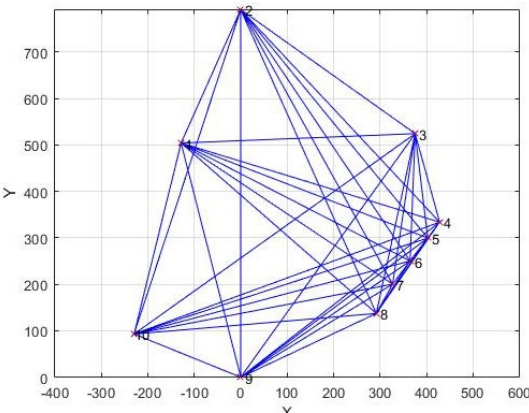
Figure 1: Network setup with connected observations (meters) Multiple localized reference solutions were calculated fixing different points. Each of these solutions fixed 3 of the 10 nodes from the solved 2-9 solution. These multiple local solutions are the 3-constraint solutions. Each of these 3-constraint solutions minimizes the RMSE when compared to the 2-9 solution. The solutions used the same observations and gave the location of each free node. An example of the distribution of the 3-constraint local solution can be seen in Fig. 2. These multiple solutions demonstrate the lowest RMSE local 3-constraint solutions around point 2. The black point represents the 2-9 solution while each blue cross represents a unique 3-constraint solution.